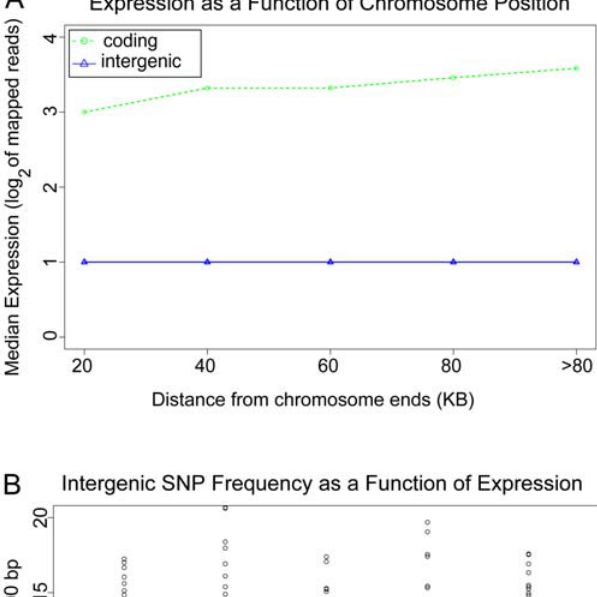
Table 1. Yeast strains used in this